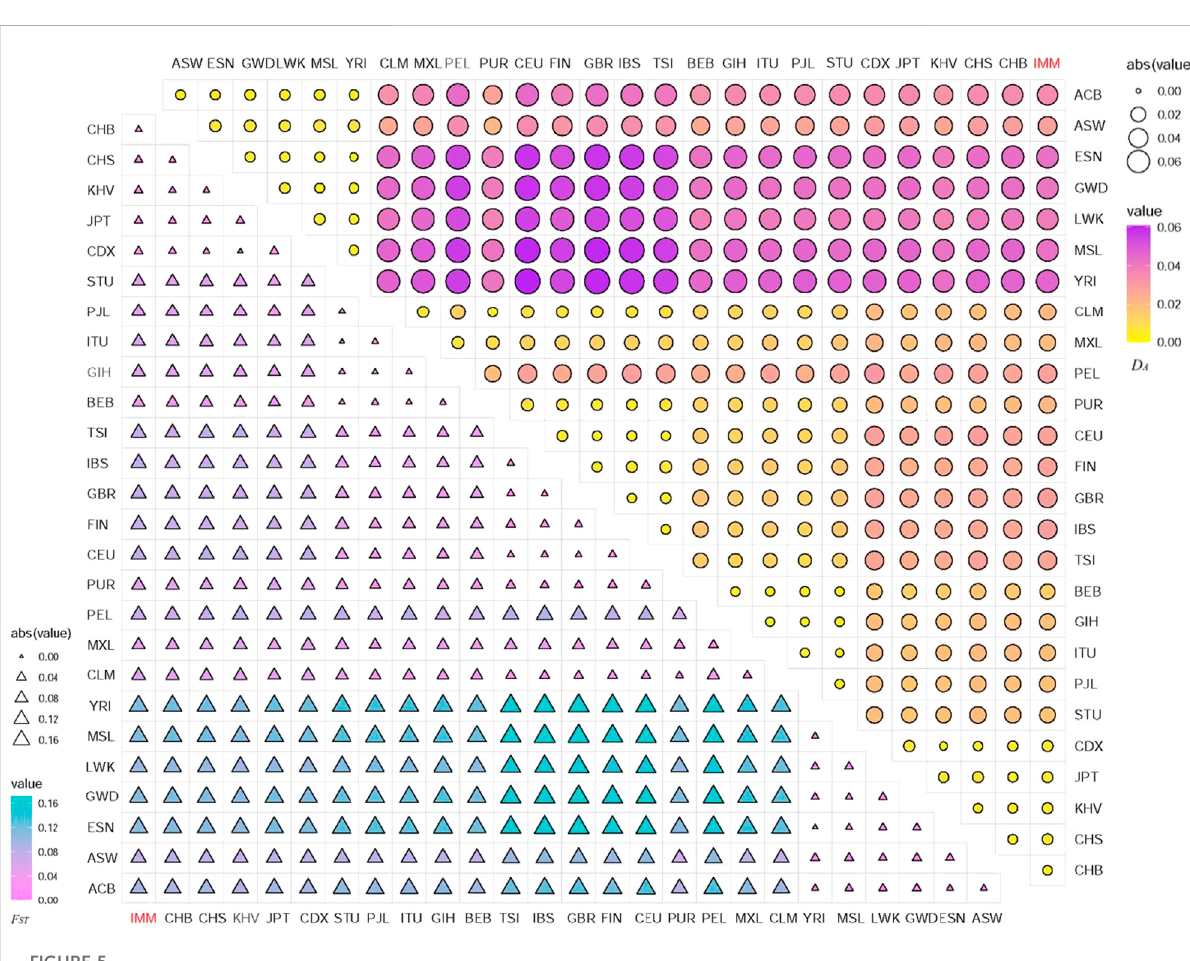
FIGURE 5 Heatmaps of the pairwise D A and F ST values among IMM group and 26 reference populations based on the 111 overlapped